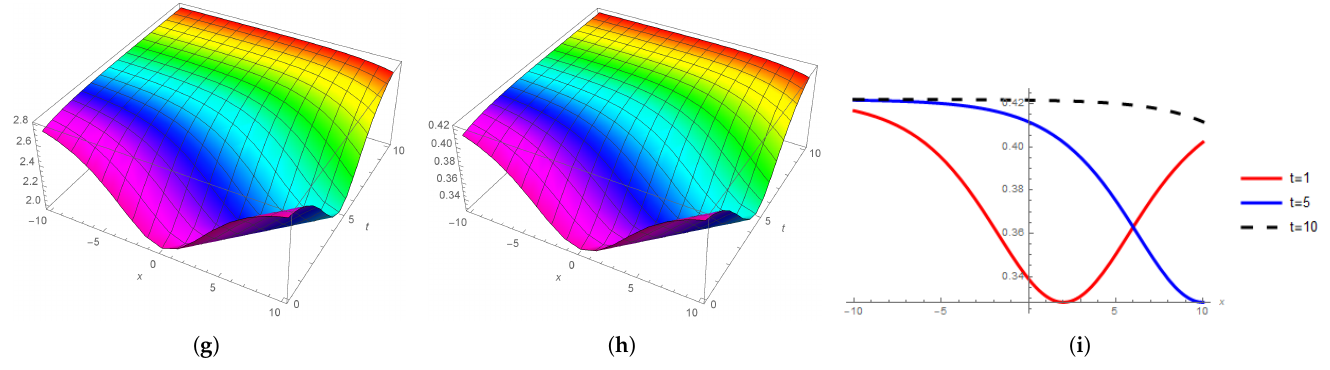
Figure 4. The 3D, contour, and 2D behavior comparison for V 1 ( ξ ) ; ( a ) 3D wave profile at wave number λ = 2.5; ( b ) contour wave profile at wave number λ = 2.5; ( c ) 2D wave profile at wave number λ = 2.5; ( d ) 3D wave profile at wave number λ = 1.5; ( e ) contour wave profile at wave number λ = 1.5; ( f ) 2D wave profile at wave number λ = 1.5; ( g ) 3D wave profile at wave number λ = 0.5; ( h ) contour wave profile at wave number λ = 0.5; ( i ) 2D wave profile at wave number λ = 0.5.